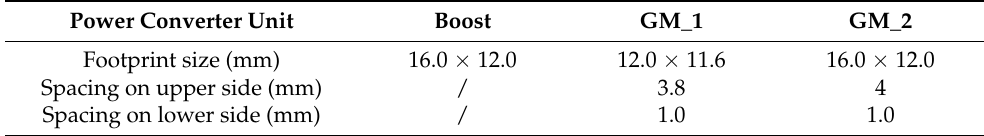
Table 2. The footprint size and spacing of parallel IGBT